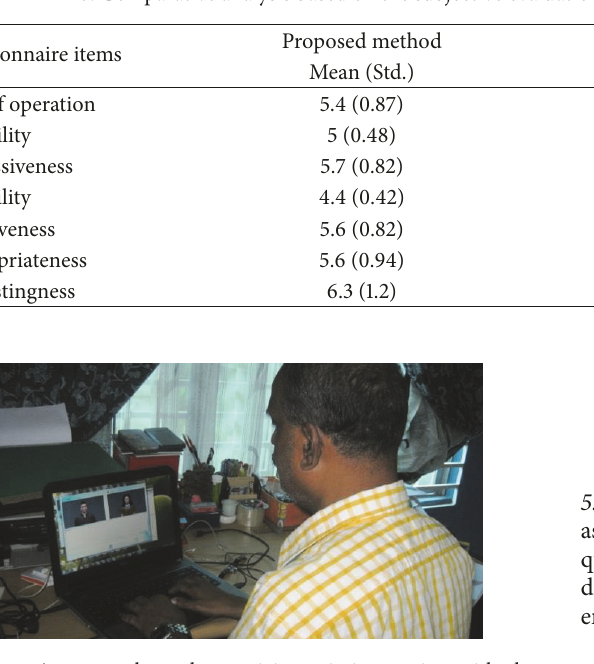
Figure 7: A scene where the participant is interacting with the proposed